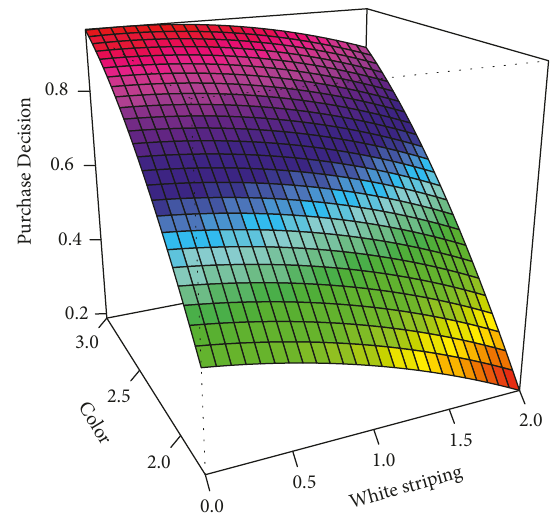
Figure 3: Influence of color and WS on the Purchase Decision ( t 24 h and 72h). (cid:31)